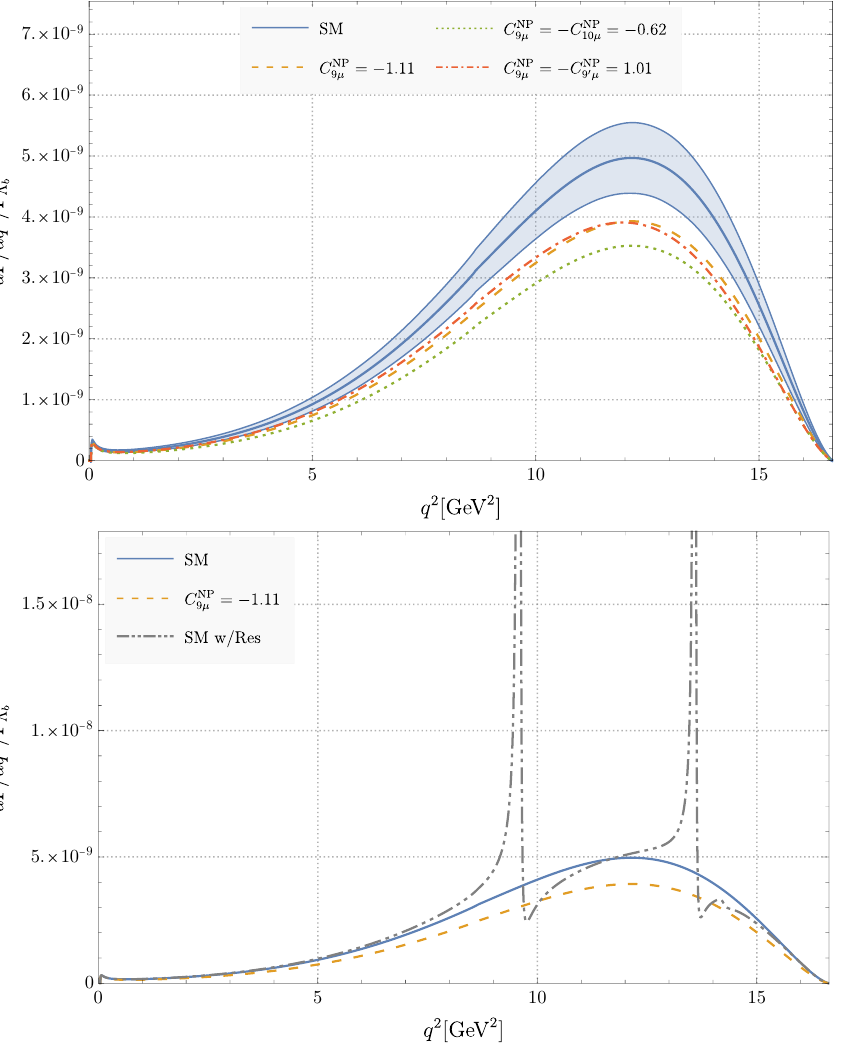
Figure 2 . Top: Di(cid:11)erential decay rate (normalised to the total (cid:3) b decay width) in the SM case and three NP scenarios. Only short-distance contributions from charm loops are include. Bottom: For illustration only, we also show the e(cid:11)ect of a model for charmonium resonances in the SM case